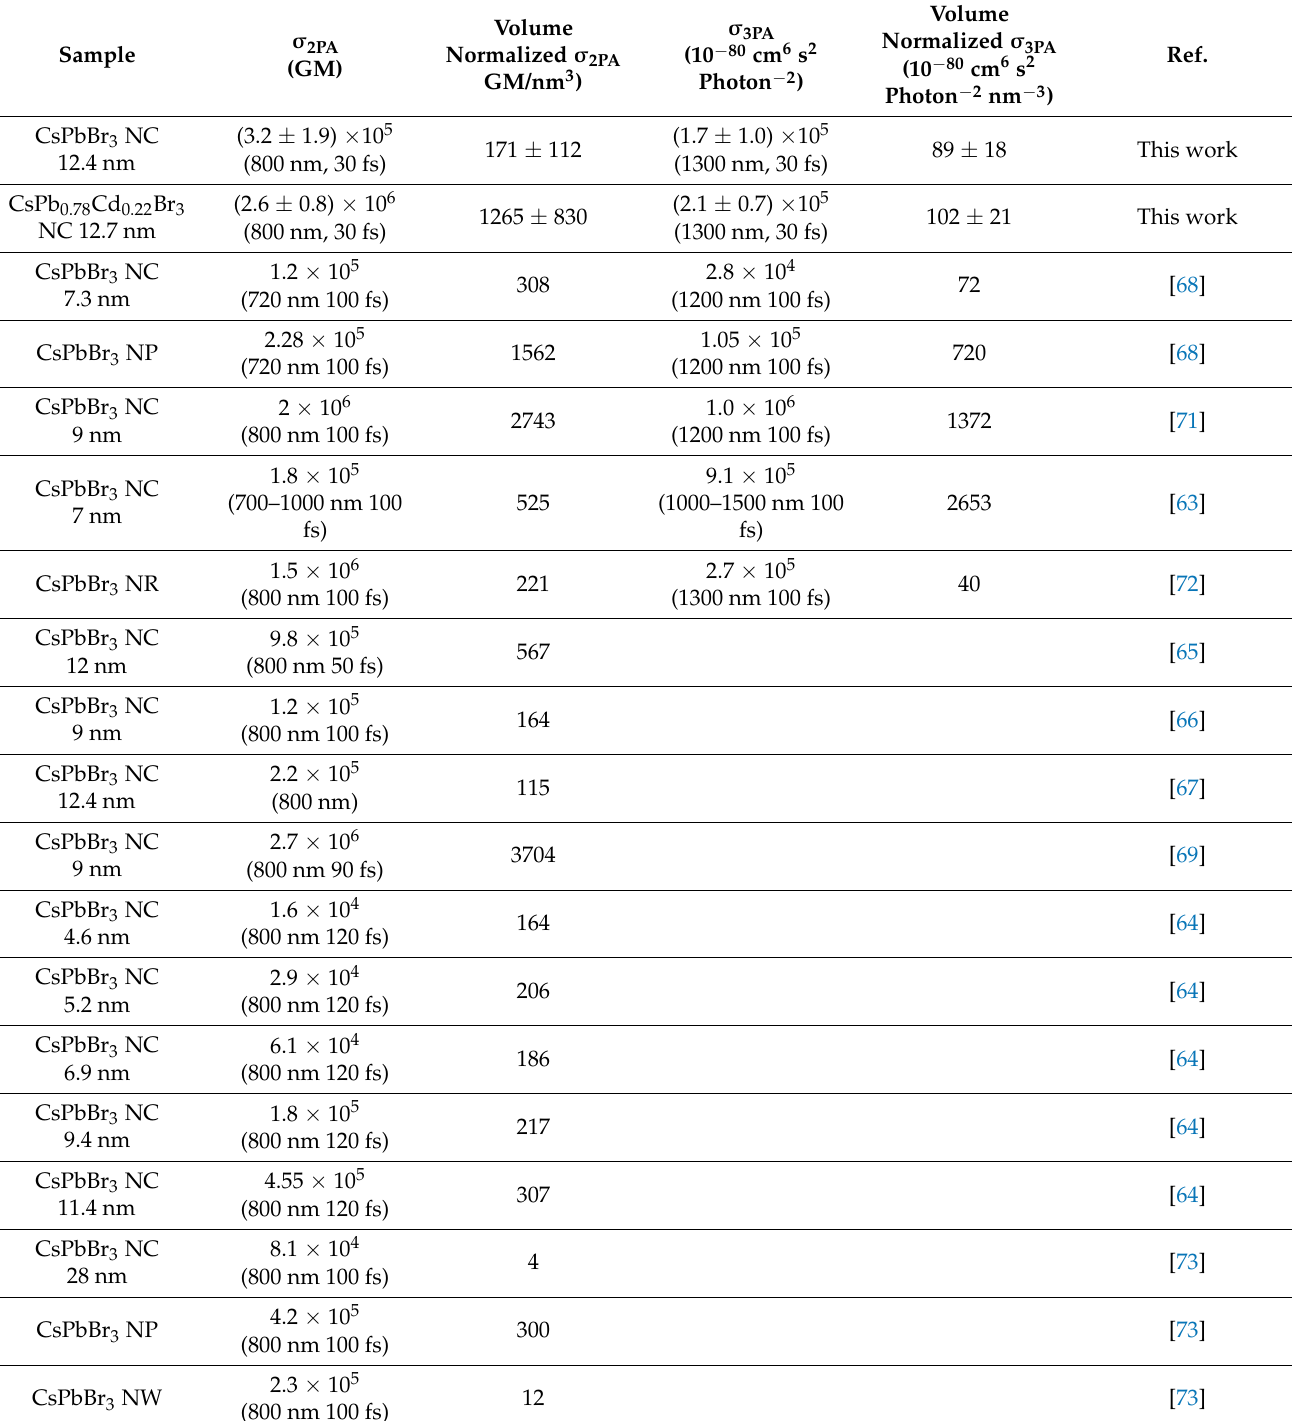
Table 1. Pristine and volume-normalized 2PA and 3PA cross-sections for the CsPbBr 3 NCs, nanoplatelets (NP), nanorods (NR), and nanowires